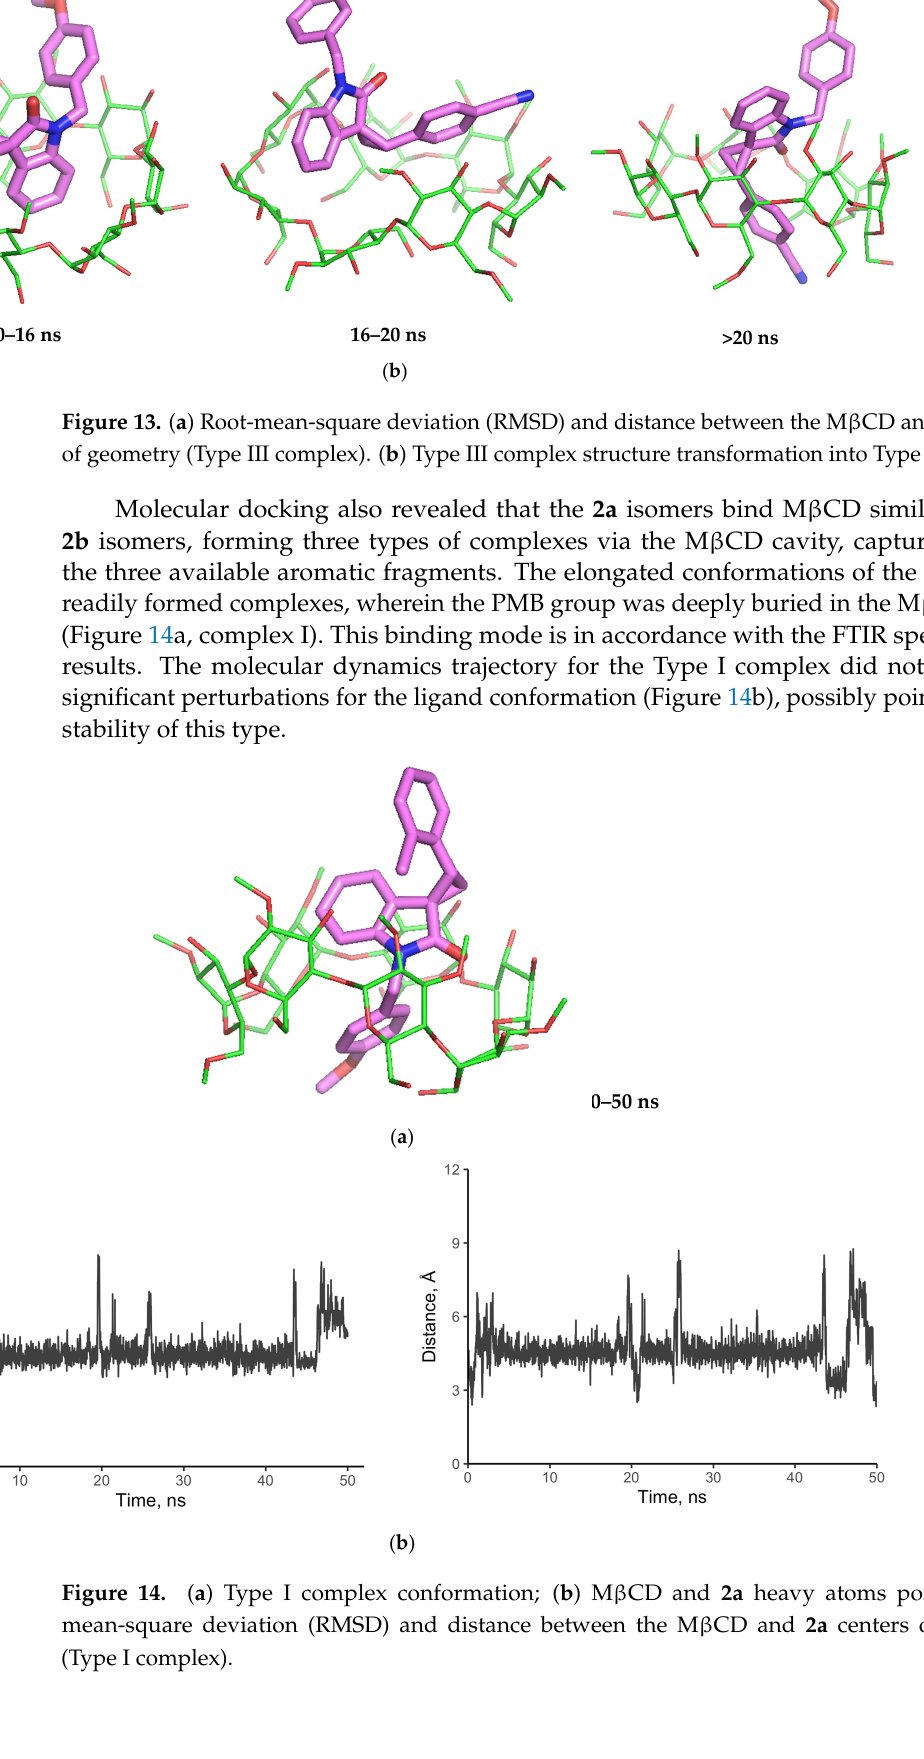
Figure 14. ( a ) Type I complex conformation; ( b ) M β CD and 2a heavy atoms positions root-mean-square deviation (RMSD) and distance between the M β CD and 2a centers of geometry (Type I complex).